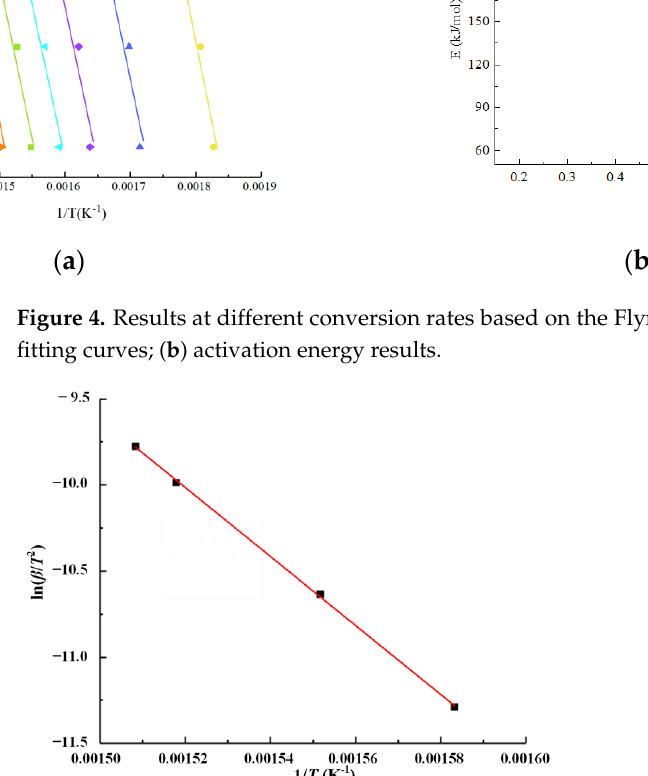
Figure 5. Linear fitting results at the maximum thermal decomposition rate based on the Kissinger method.